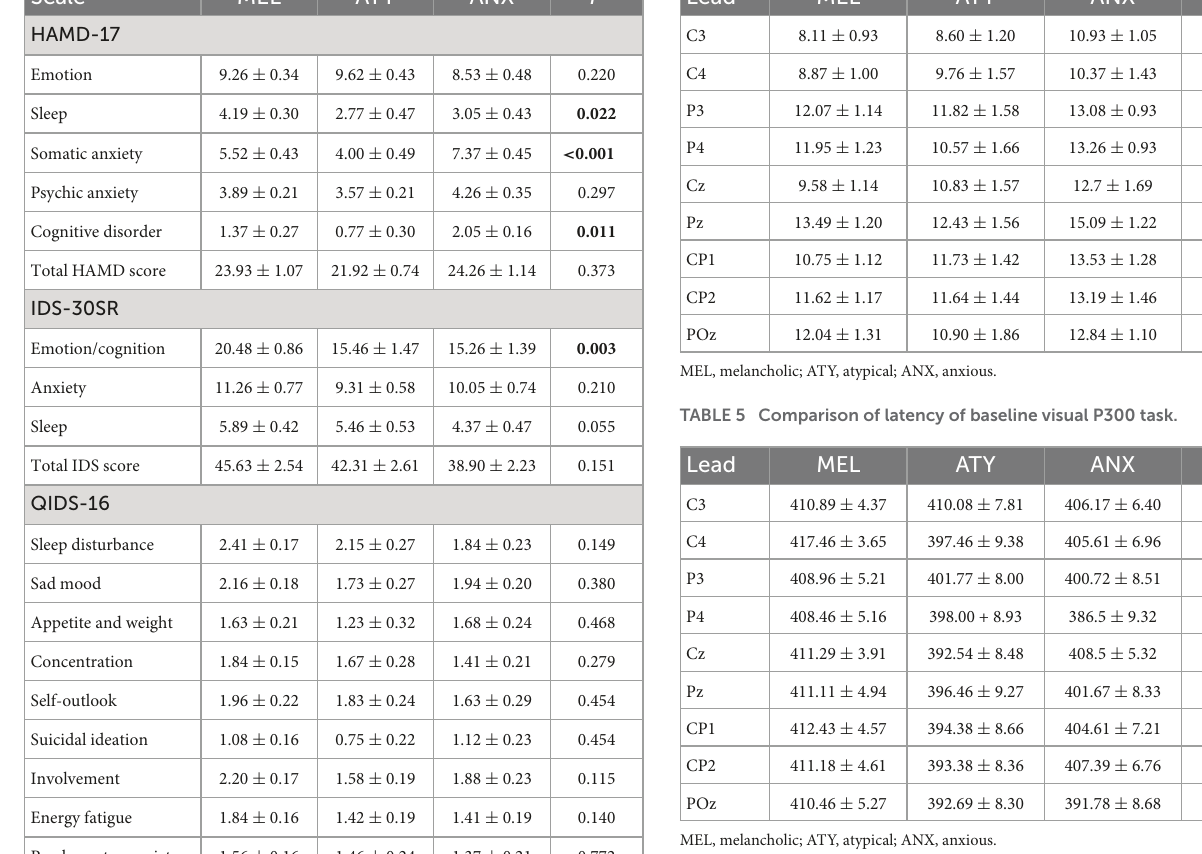
TABLE 4 Comparison of amplitude of baseline auditory P300 task. Lead MEL ATY ANX